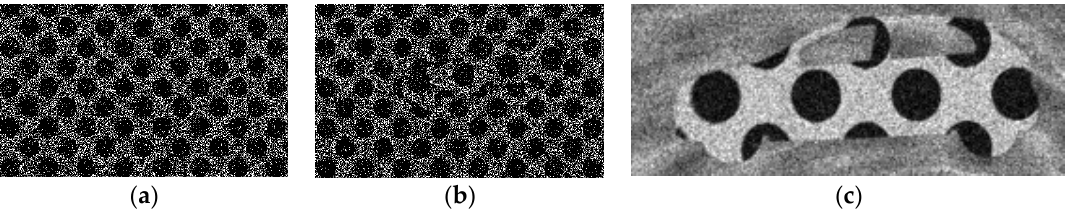
Figure 7. Results for synthetic data with both car and background featuring identical dotted patterns with photon rates H 1 = 0.35 (in dot) and H 2 = 0.05 (elsewhere). ( a ) Bit-plane at time i = 1; ( b ) Bit-plane at time i = 36; ( c ) Reconstructed vehicle (shown over a region of interest of 230 × 90). The quality of the reconstruction is R = 0.960.